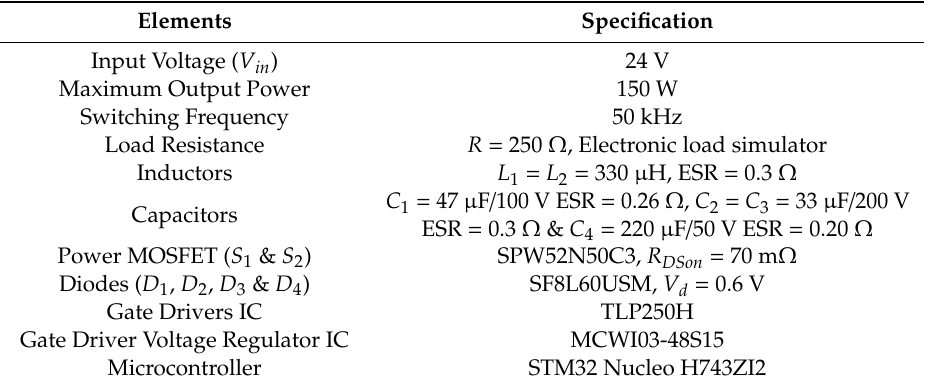
Figure 13. ( a ) Proposed converter; ( b ) experimental set-up. Table 3. Specifications of the proposed